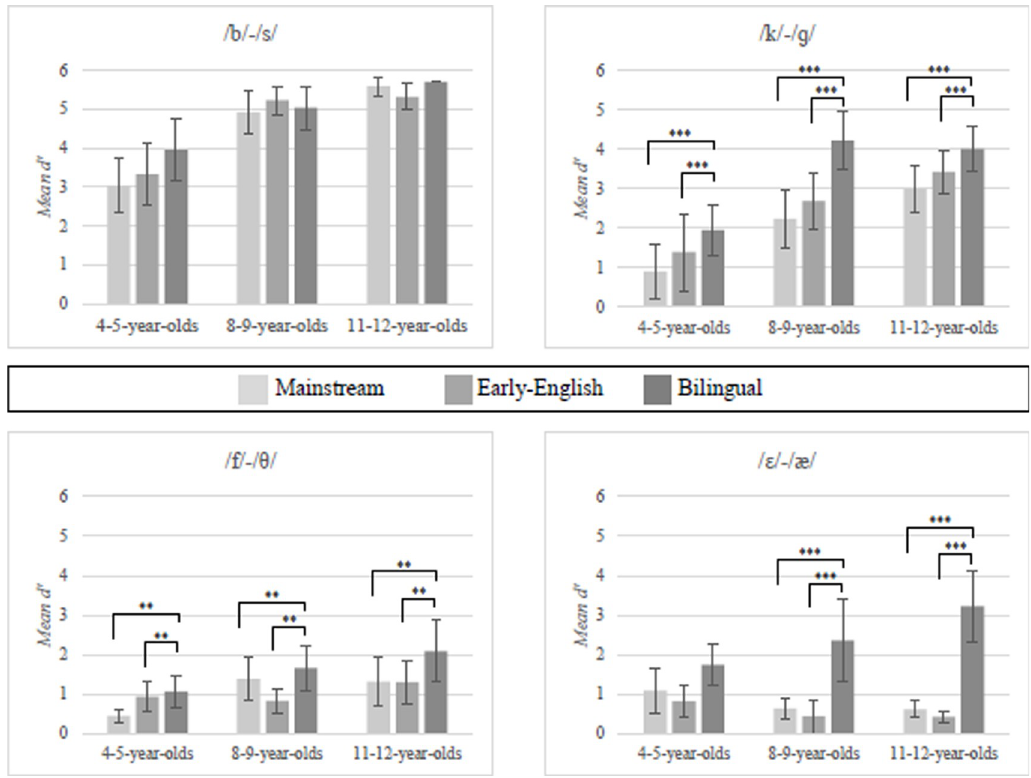
Fig 2. Mean values (with SD ) for d’ , for each group separately. Pairwise significant differences (Tukey post hoc tests) are indicated with � p < .05, �� p < .01, ��� p � .001.